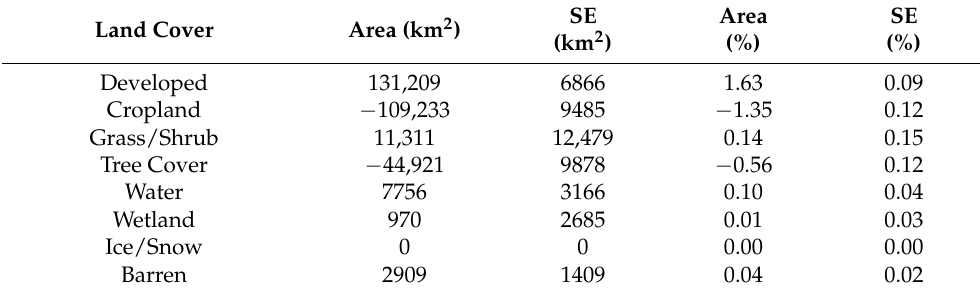
Table 1. CONUS land-cover estimated area and net percent change between 1985 and 2016.